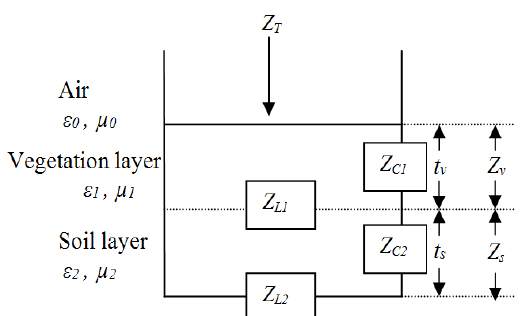
Fig.1. Two-dimensional diagram for two-layer modelling approach ( Al- Bilbisi et al., 2004)